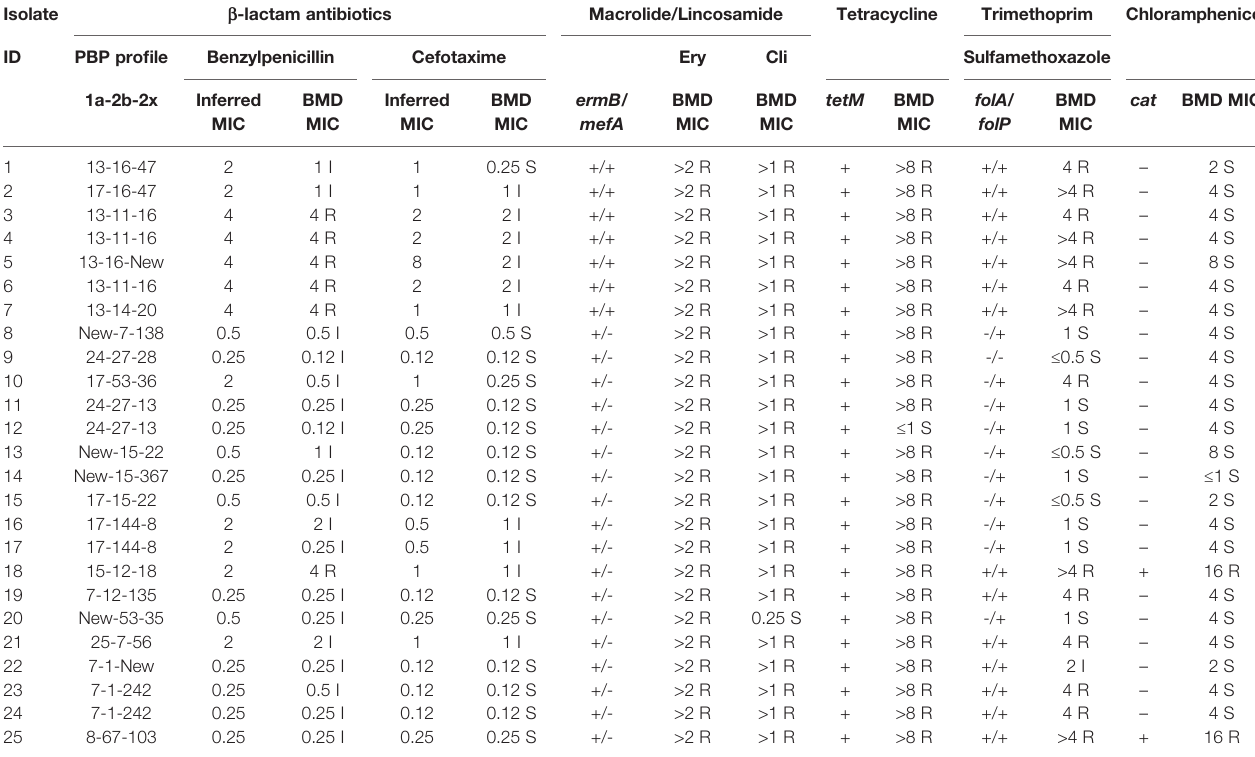
TABLE 2 | Phenotypic and genotypic antimicrobial susceptibility correspondence was high.